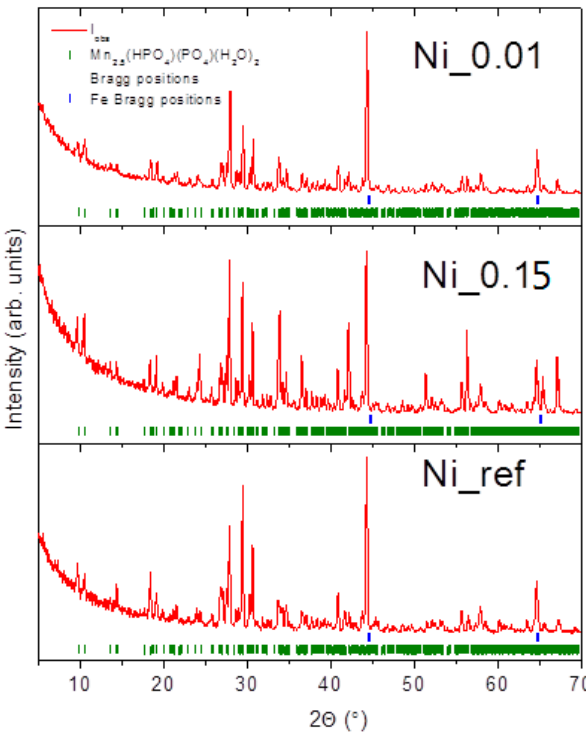
Figure 7. XRD patterns for the samples Ni_0.01, Ni_0.15, and Ni_ref. Solid red lines are measured patterns, the green tickmarks correspond to the Mn 2.5 (HPO 4 )(PO 4 )(H 2 O) 2 phase, and the blue tickmarks correspond to iron.